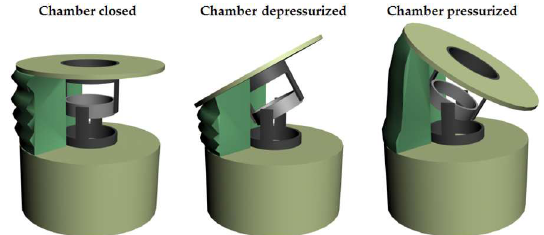
Figure 2: The figure shows one of the three chambers that are mounted around each joint. By ap- plying pressurized air to a chamber, it will expand and move the